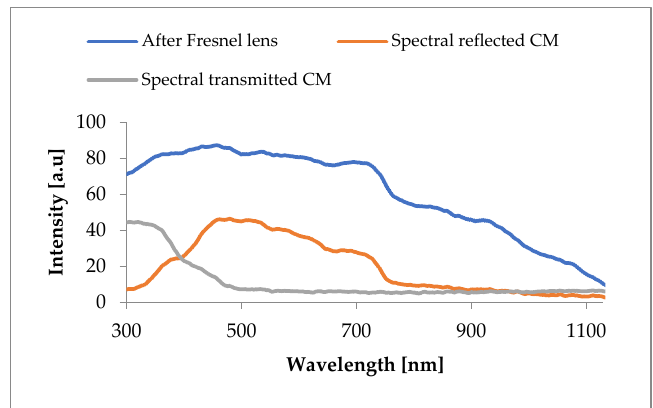
Figure 9. The halogen light spectrum reflected and transmitted by cold mirror.